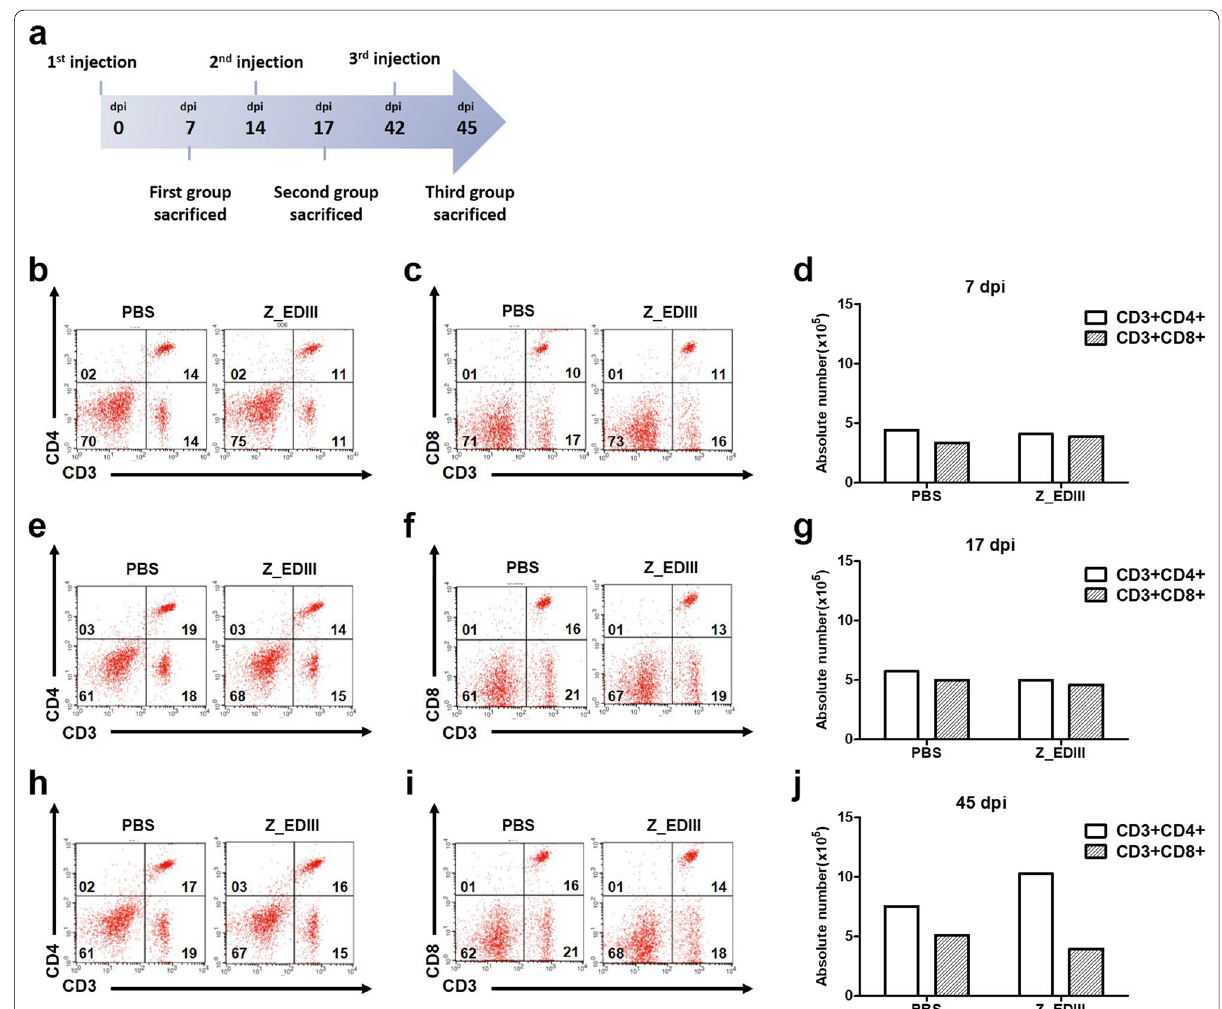
Fig. 3 CD4 + and CD8 + T cells population in immunized mice. a Experimental procedure for cellular immune response. C57BL/6 mice ( n immunized with Z_EDIII or PBS at 0, 14, and 42 dpi. Mice were euthanized at 7, 17, and 45 dpi (7 dpi; b – d , 17 dpi; e – g , 45 dpi; h – j ). Total splenocytes were collected from five mice in each group and stained with antibodies to CD3, CD4, and CD8